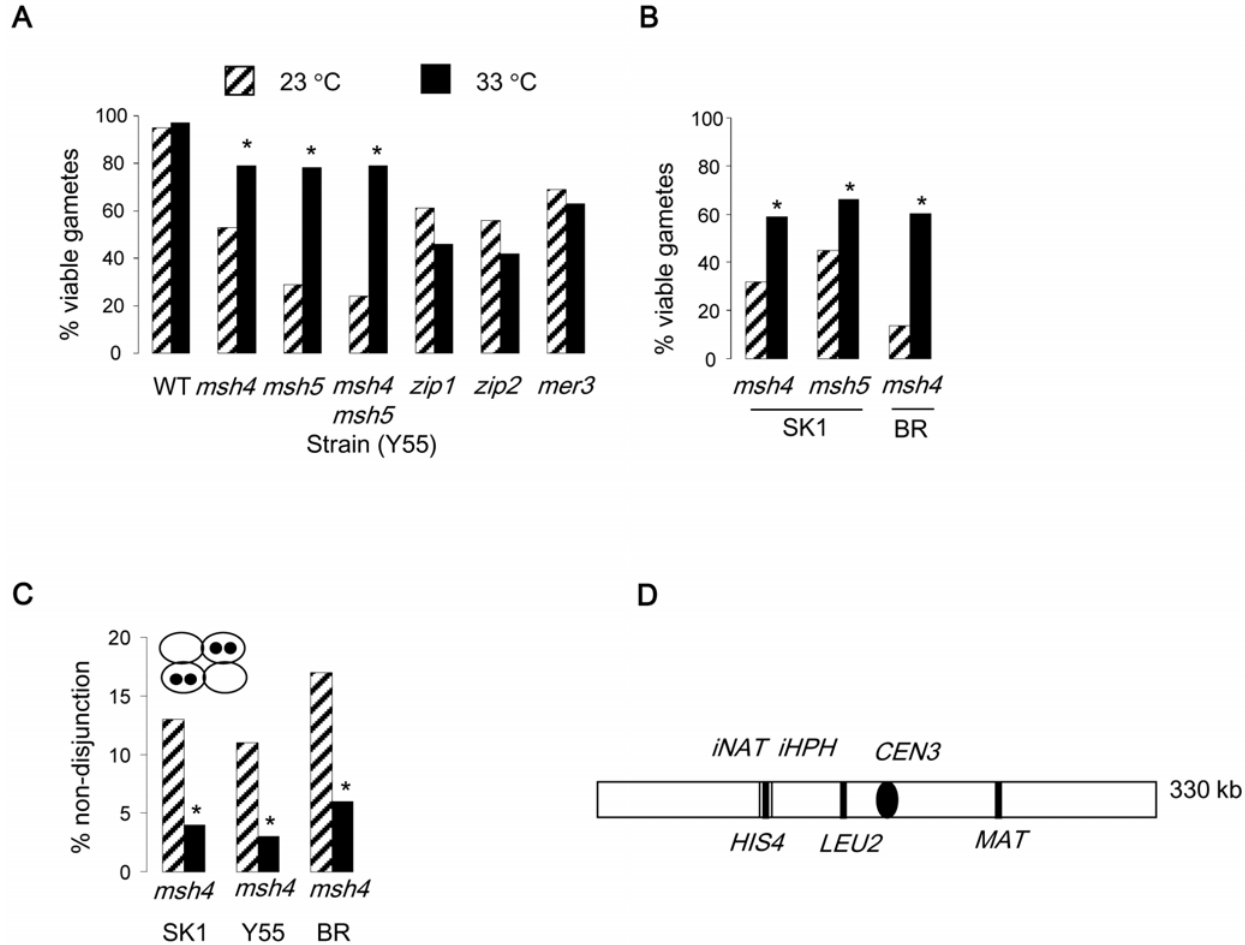
Figure 1. Chromosome segregation and spore viability in the msh4 and msh5 mutants is modulated by temperature. (A) Spore viabilities of zmm mutants in the Y55 strain background and of msh4 in BR and SK1 (B). Strains are given in Supplementary Table S1 and viable-spore class distributions in Table 1 (Y55) and Table 2 (SK1). Spore viability was measured by counting viable spores in dissected tetrads. (C) Assessment of meiosis I non-disjunction in spores containing LacO or TetO labelled chromosome IIIs and expressing LacI-GFP or TetR-GFP, respectively. More than 150 tetrads containing four distinct GFP foci were examined using standard fluorescence microscopy. For isogenic wild-type strains, the missegregation frequencies were less than 1/150 (data not shown). The asterisks indicate statistically significantly improved viability frequencies (A and B) and improved segregation (C) compared to 23 u (P , 0.01, G-test for homogeneity). Hatched bars represent assays at 23 u and black bars at 33 u .